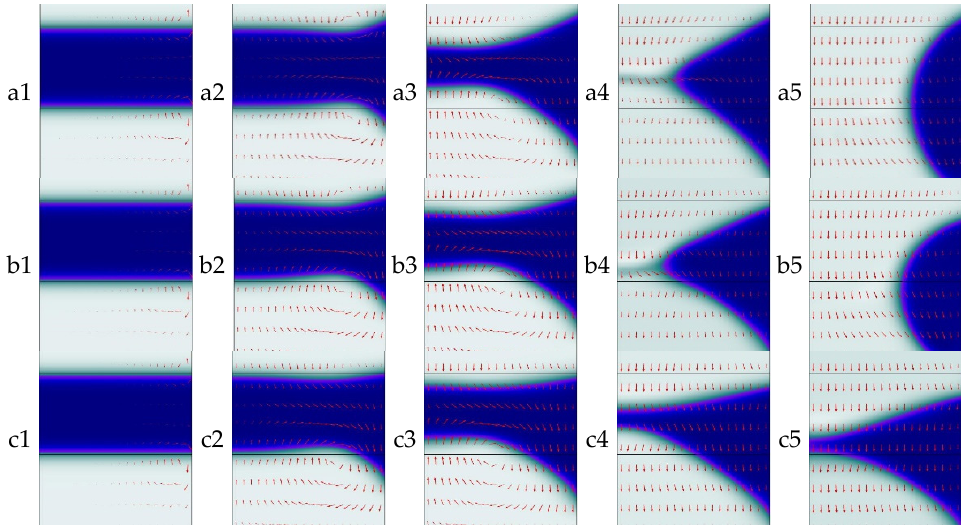
Figure 8. Two-phase transport state under each wettability phase when the inlet pressure is 100 Pa and the aperture radius is 15 µ m. ( a ) is contact angle 60 ◦ , ( b ) is 70 ◦ , and ( c ) is 80 ◦ . The arrow in the picture is the velocity vector direction of the gas particles, the liquid phase is blue, and the gas phase is green. The 1–5 in figure are instantaneous graphs with time increasing in